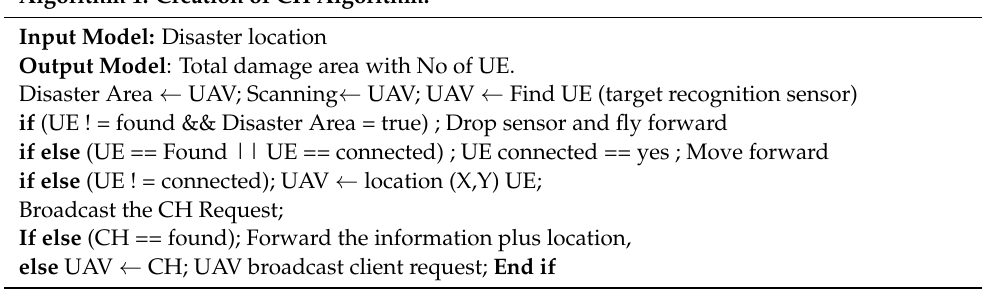
Algorithm 1: Creation of CH